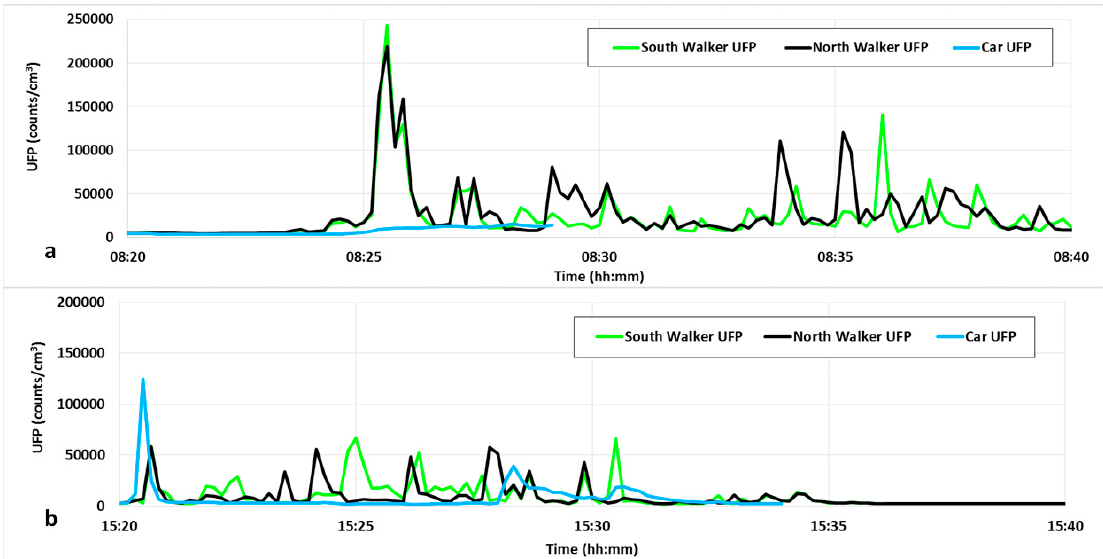
Figure 4. Example of UFP exposure for a commute ( a ) 17 November 2015 morning and ( b ) 12 November 2015 afternoon for the two walking routes and the car commuter. Note the peak in concentration that occurs shortly after 8:25 a.m. for the pedestrians when they reach a partially enclosed stretch of road and the shorter duration of the commutes for the car